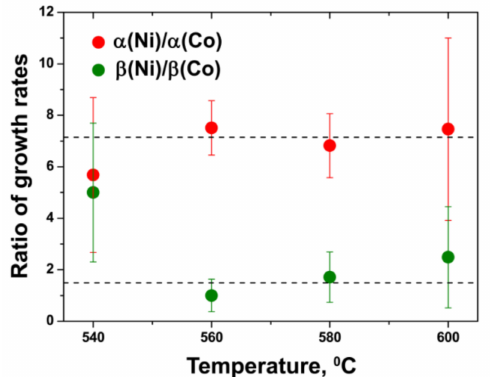
Figure 19. The ratios of the rates α (red) and β (green) of the growth of the (12,3) inner tube inside the nickelocene- and cobaltocene-filled SWCNTs plotted versus annealing temperature. The dashed horizontal lines denote the average values of the ratios of the growth rates for different annealing